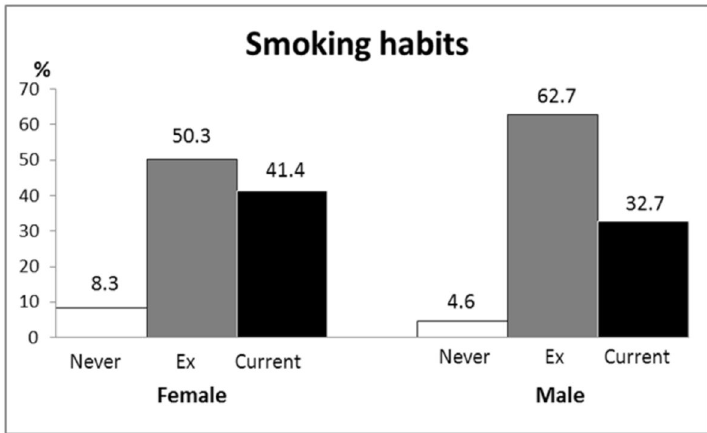
Figure 2. Smoking habits during the last two years before death in 325 women and 350 men with COPD. There is a gender difference in never-smokers (p=0.04), ex-smokers (p=0.001) and current smokers (p=0.02).